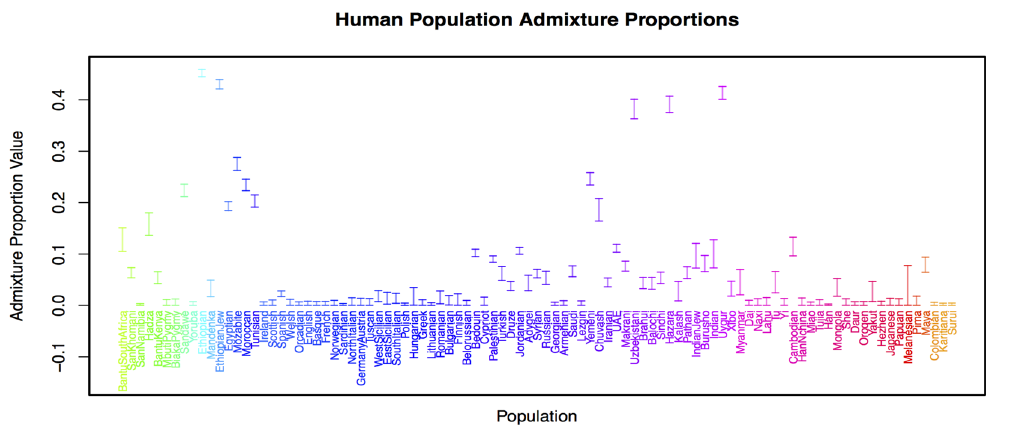
Fig 10. Admixture proportions (95% CIs) for each human population sample. Labels are colored as in as in Fig